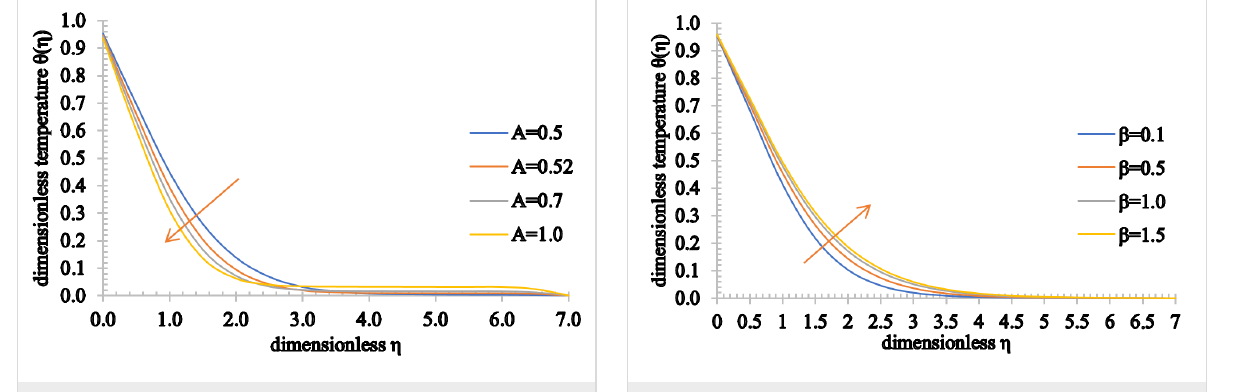
Figure 6: The temperature profile for increasing values of A .